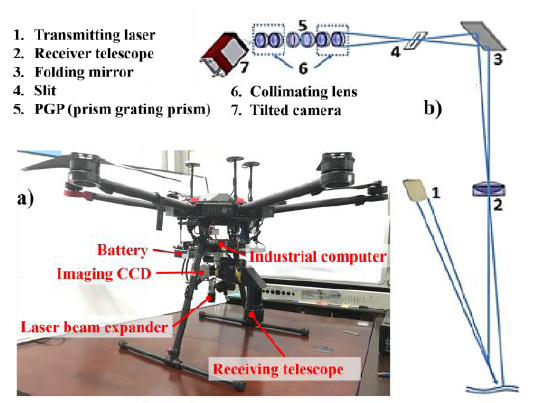
Fig. 1. a) Drone-based inelastic hyperspectral Scheimpflug lidar for vegetation monitoring; b) Schematic of the lidar system, modified from